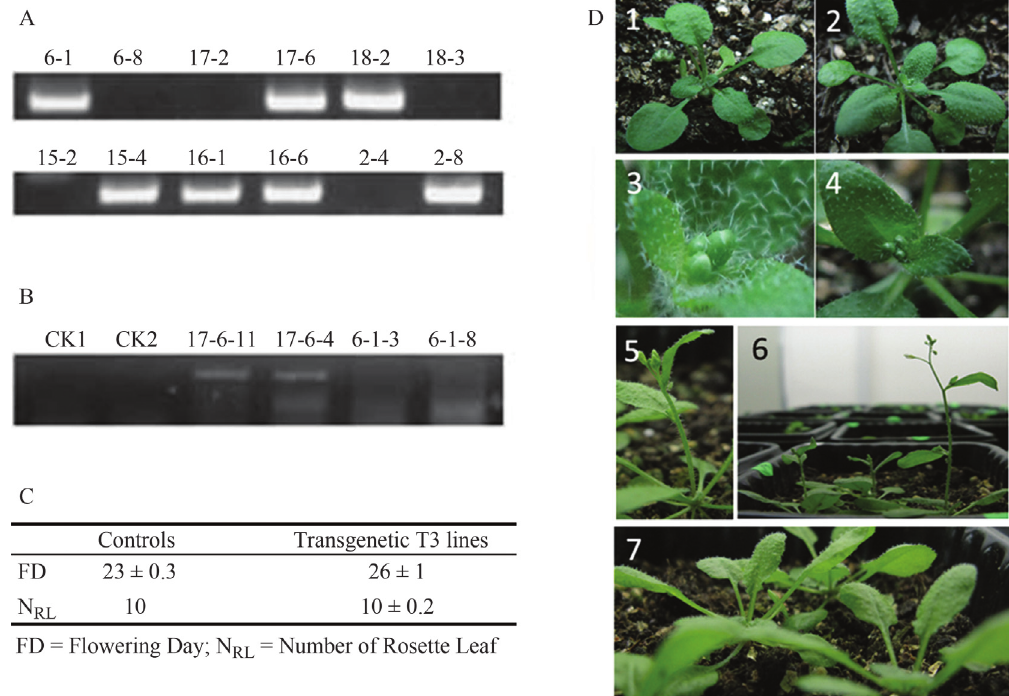
Figure4 -Identificationandcharacterizationoftransgenicandwild-type Arabidopsis .(A)Hpt(hygromycinphosphotransferasemarkergene)testsonT 2 plants. (B) PhmiR172 transcript detection in controls (CK, transgenic Arabidopsis with empty vector) and experimental groups (positive T 3 transgenic plants with PhmiR172 ). (C) Statistics of flowering days (FD, start from seeding, p = 0.02) and number of rosette leaves (NRL) when blossoming (p = 0.4) ofT 3 PhmiR172-2 -expressingplantsandcontrols.(D)Phenotypesofcontrol(transgenic Arabidopsis withemptyvector)andexperimental(T 3 )plants.(1) Controls on the 23 rd day of growth in which there was no flowering, (2) Transgenic plants starting to flower on day 23, (3) Transgenic buds on day 23, (4) Transgenic buds on day 26, (5) Transgenic plant on day 26, (6) Transgenic plants on day 29, and (7) Control plant starting to flower on day